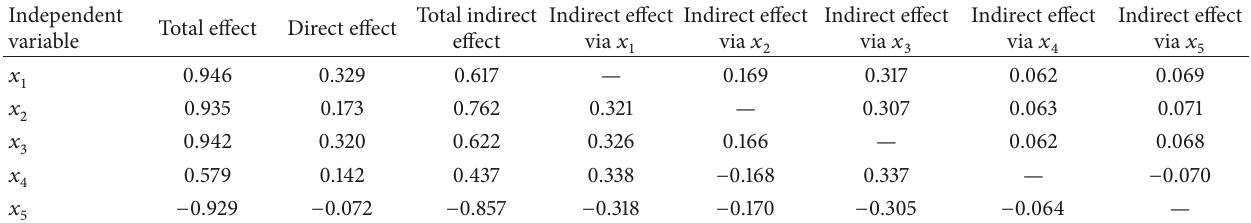
Table 2: The direct and indirect contributions of different affecting factors to the electricity demand of China. Independent